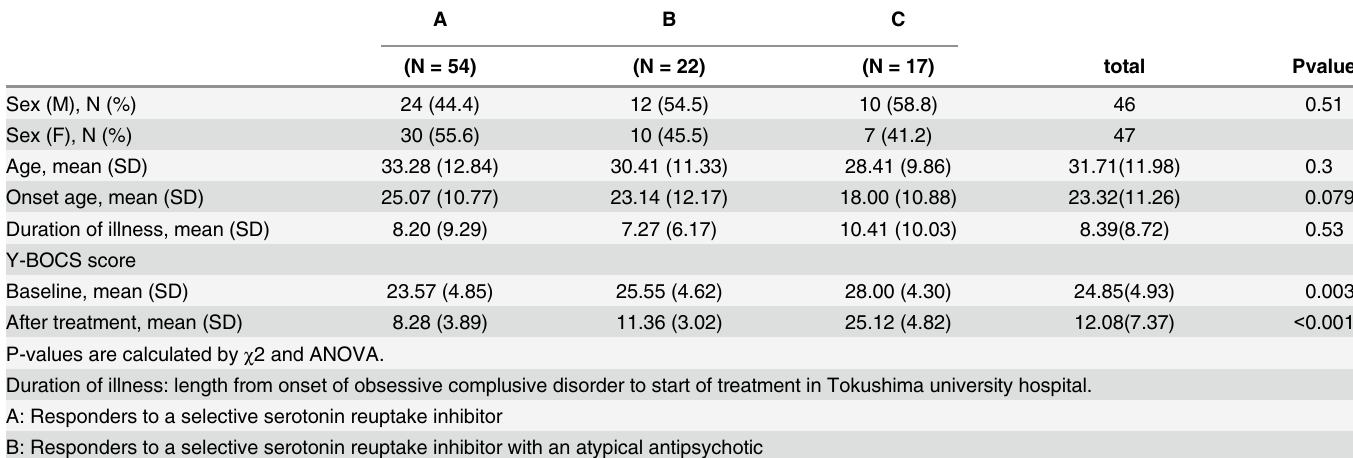
Table 1. Treatment response group and clinical symptoms of patients with obsessive-compulsive